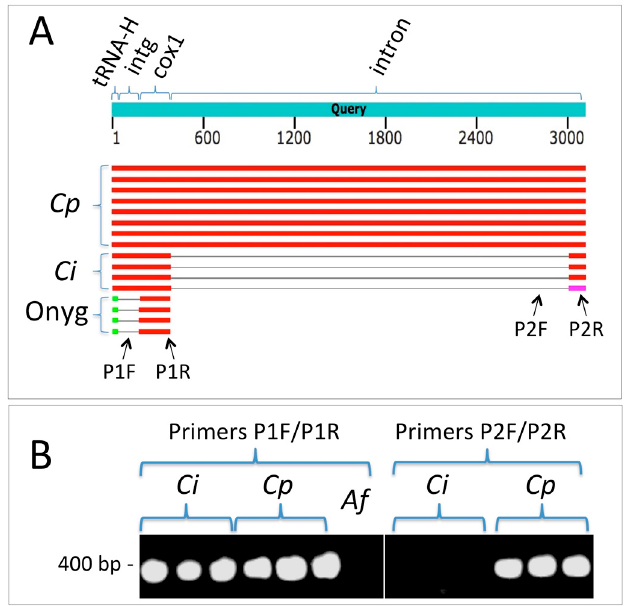
Figure 2. An mtDNA region can be employed to distinguish between C. immitis and C. posadasii using PCR. (A) Summary results from a BLASTN search employing the cox1 mtDNA region from C. posadasii strain C735 delta SOWgp (GenBank: ACFW01000039). Cp = hits against C. posadasii sequences, Ci = hits against C. immitis , and Onyg = hits against other Onygenales ( Microsporum canis CBS 113480, Trichophyton interdigitale M8436, Trichophyton mentagrophytes TIMM 2789, and Trichophyton interdigitale H6). Note that the gap in the intron of C. immitis relative to C. posadasii represents a large indel. The intergenic region (intg) between the histidine tRNA and cox1 is conserved between the two Coccidioides species but not between the latter and other Onygenales. The sequence corresponding to primer P1F is present in both Coccidioides species but not in other genera for which sequences are currently available in Genbank. The P1R sequence is contained within the first cox1 exon and is conserved in both species. The P2F primer sequence is entirely absent from C. immitis . The P2R primer sequence is wholly contained within the C. posadasii intron but spans the predicted exon–intron border of C. immitis . (B) Primer pair P1F/P1R amplifies a fragment from both